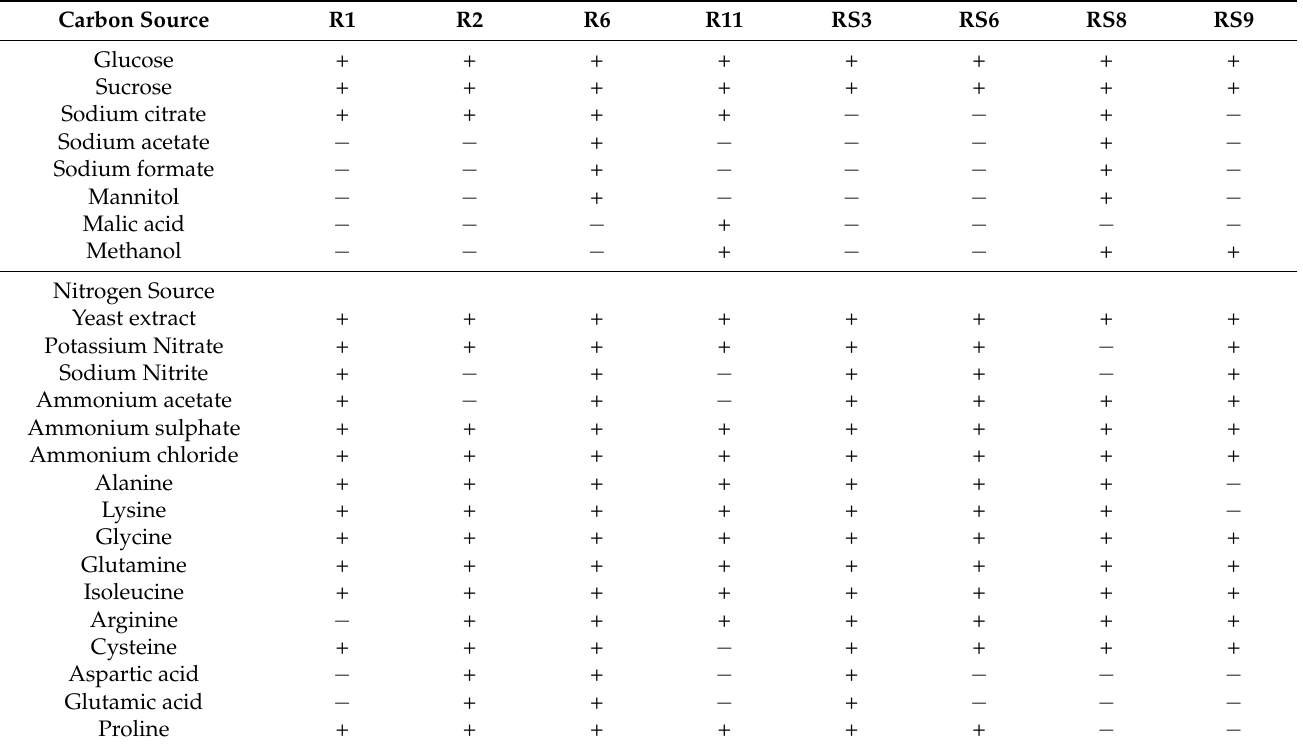
Table 3. Carbon and nitrogen source utilization patterns of endophytic bacterial